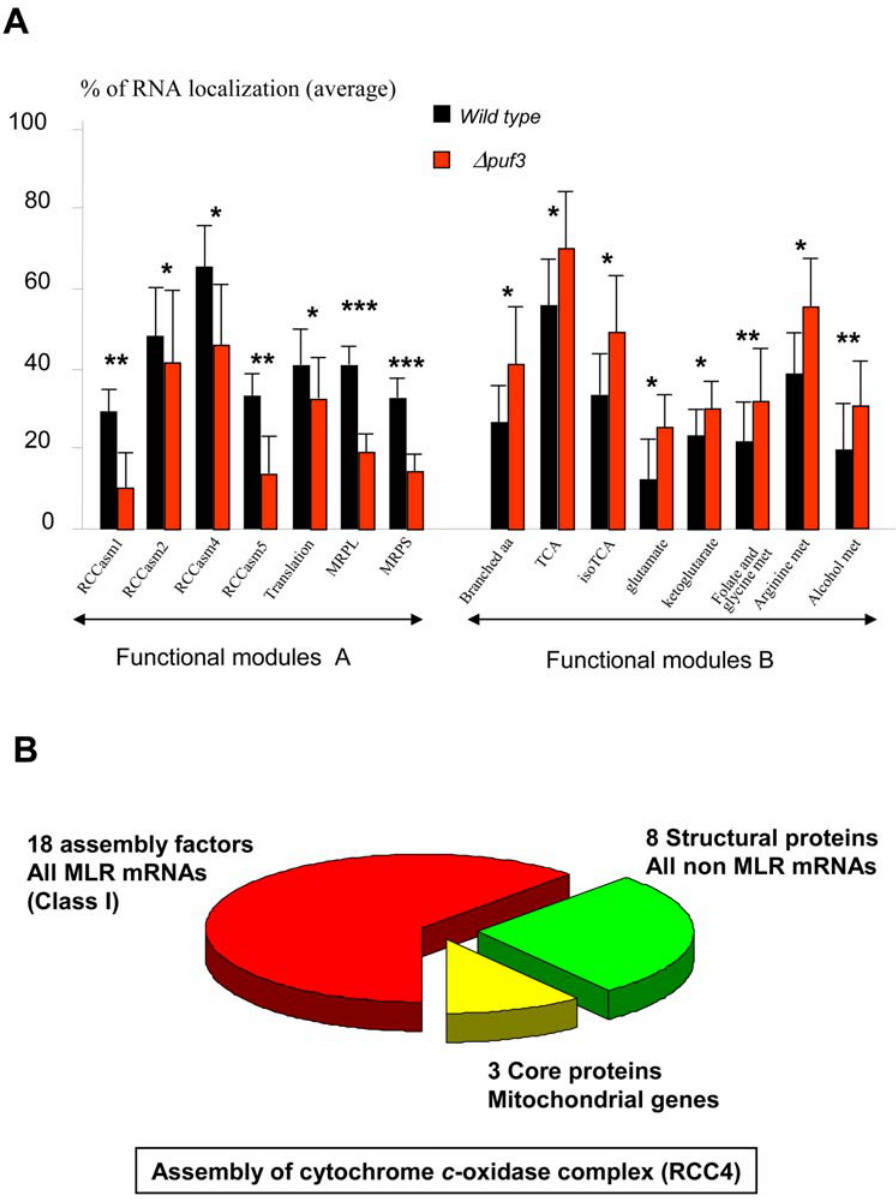
Figure 4. PUF3 deletion affects the asymmetric localization of different functional modules differently. A: Distribution of D puf3 effects on some of the mitochondrial functional modules described by Perocchi [5]. Only the functional modules for which average MLR value was significantly affected in the D puf3 strain have been represented. The mean RNA localization value of each functional module is either decreased (class A) or increased (class B). Asterisks denote the p values (Student test) of each wild type versus mutant differences: * =p , 0.05, ** =p , 0.01, *** =p , 0.001. All A-type functional modules are involved in translation orare assembly factors: thus RCCasm modules (1 to 5) include 29 genes ( ATP11, ATP12, SHY1, COX17 , etc…); translation module includes 15 genes mainly involved in mitochondrial translation control ( CBS2, CBP6, PET494 , etc…); MRPL and MRPS contain 48 and 37 genes codingformitochondrial ribosomal proteinsrespectively; B-type functionalmodulesconcern metabolicpathways: Branched aa (10 genes),TCA (13 genes), isoTCA (6 genes), Glutamate (6 genes), Ketoglutarate (13 genes), Folate (10 genes), Arginine (5 genes), Alcohol (10 genes). Detailed for all these modules can be found in [5] and in Table S1. The significant increased mean MLR value after PUF3 deletion might be the consequence of the modification of the global PUF proteins due to the absence of Puf3p. B. The specific example of cytochrome c-oxidase complex biogenesis (RCC4). Concerning the nuclear encoded subunits, the 18 assembly factors necessary for the synthesis of the complex [4] are translated on polysomes linked to mitochondria whereas the 8 structural proteins are translated on cytoplasmically-free polysomes (Table S4 for gene